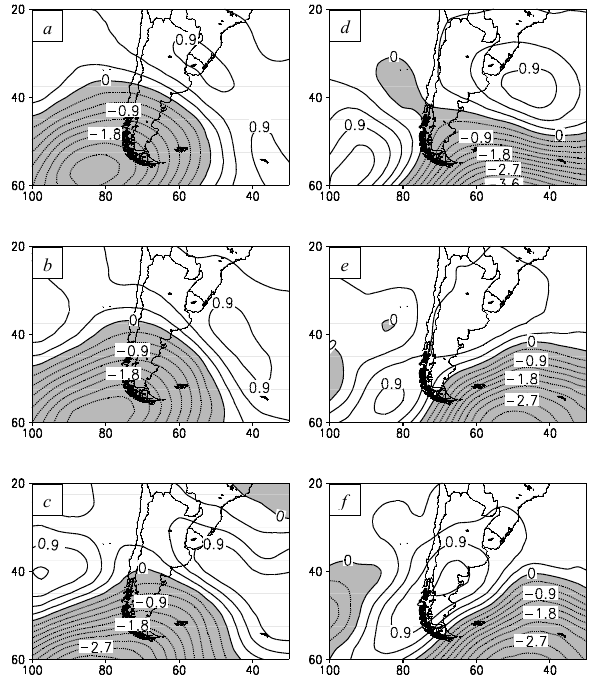
Fig. 3. Main aspects of the PCs. The left panel shows the first PC score spatial pattern, contour values are every 0.3 with shaded areas for negative score values for 700hPa (a) , 850hPa (b) 1000hPa (c) ; the right panel shows the second PC score spatial patterns – 700hPa (d) , 850hPa (e) 1000hPa (f) .